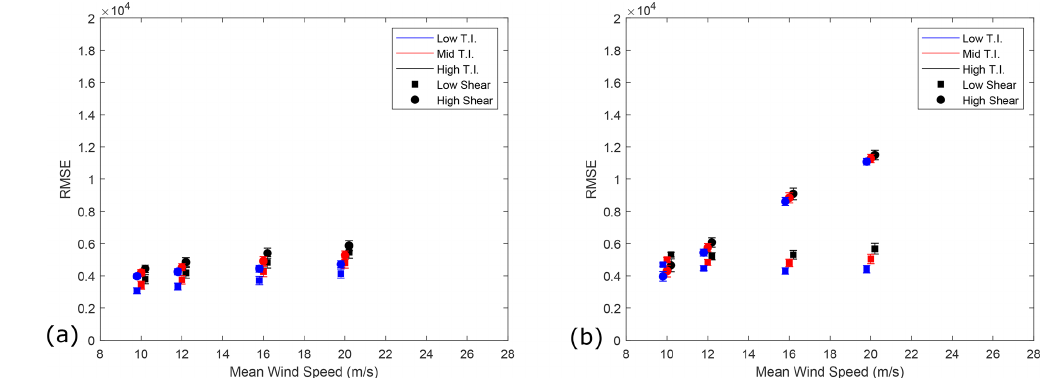
Figure 5. (a) RMSE between reaction forces from the analytical and DSRB FE model in the horizontal plane . The mean and standard deviations within each CPLS are plotted, staggered about mean wind speed for clarity. (b) RMSE reaction force results between the analytical and DSRB FE model in the vertical plane . The mean and standard deviations within each CPLS are plotted, staggered about mean wind speed for clarity.